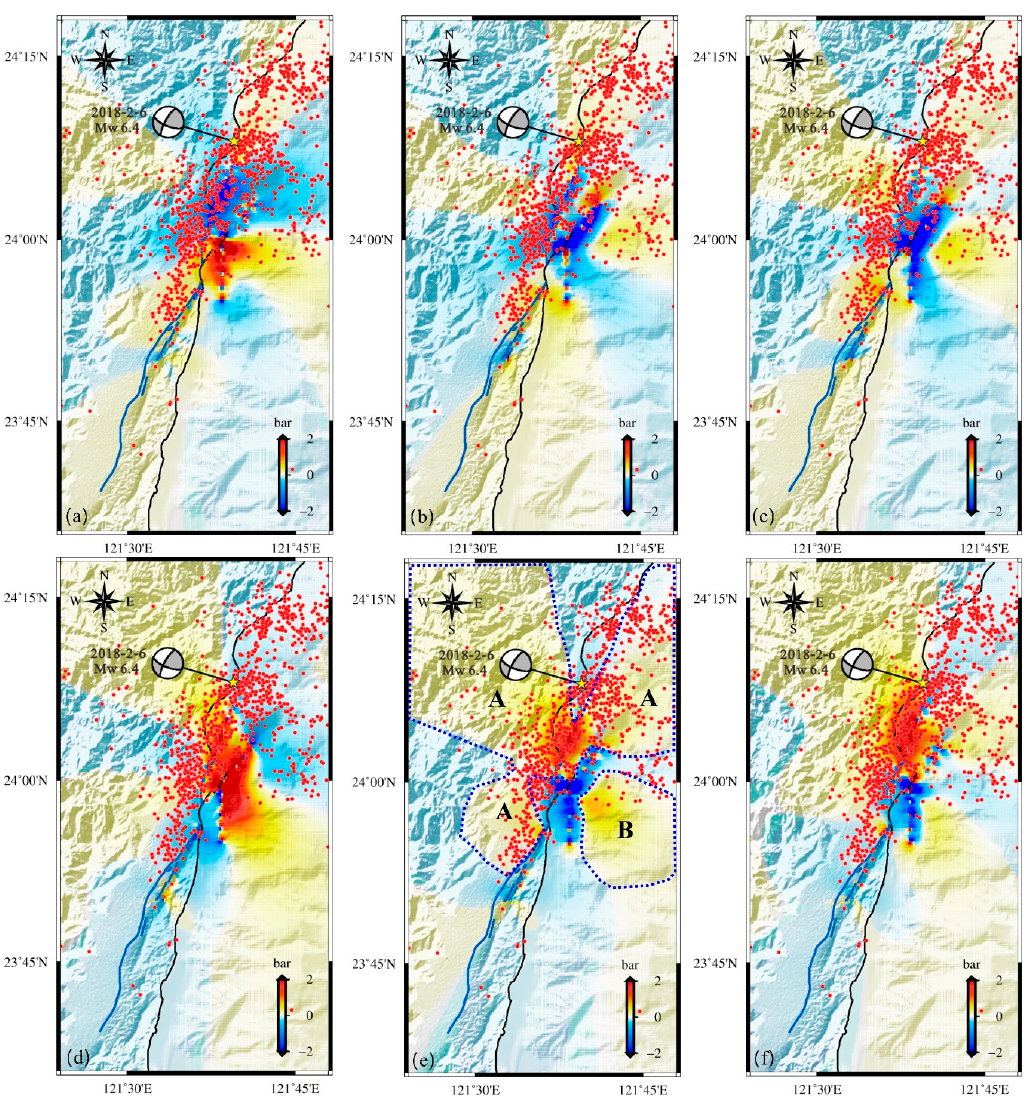
Figure 8. The Coulomb failure stress change at the depth of 10 km (the average depth of the aftershocks) with different receiver fault parameters. The red dots are the aftershocks of the 2018 Hualien earthquake, and the beach ball is the focal mechanism of the main shock of the 2018 Hualien event. The CFS change at the 10 km depth with receiver parameters of 201.7° for the strike angle, 89.4° for the dip angle, 45° ( a ) and 135° ( d ) for the rake angle. The CFS change at the 10 km depth with receiver parameters of 0.1° for the strike angle, 73.5° for the dip angle, and 45° ( b ) and 135° ( e ) for the rake angle. The CFS change at the 10 km depth with receiver parameters of 33.9° for the strike angle, 71.8° for the dip angle, and 45° ( c ) and 135° ( f ) for the rake angle. The blue dotted lines depict the significant positive CFS change areas.